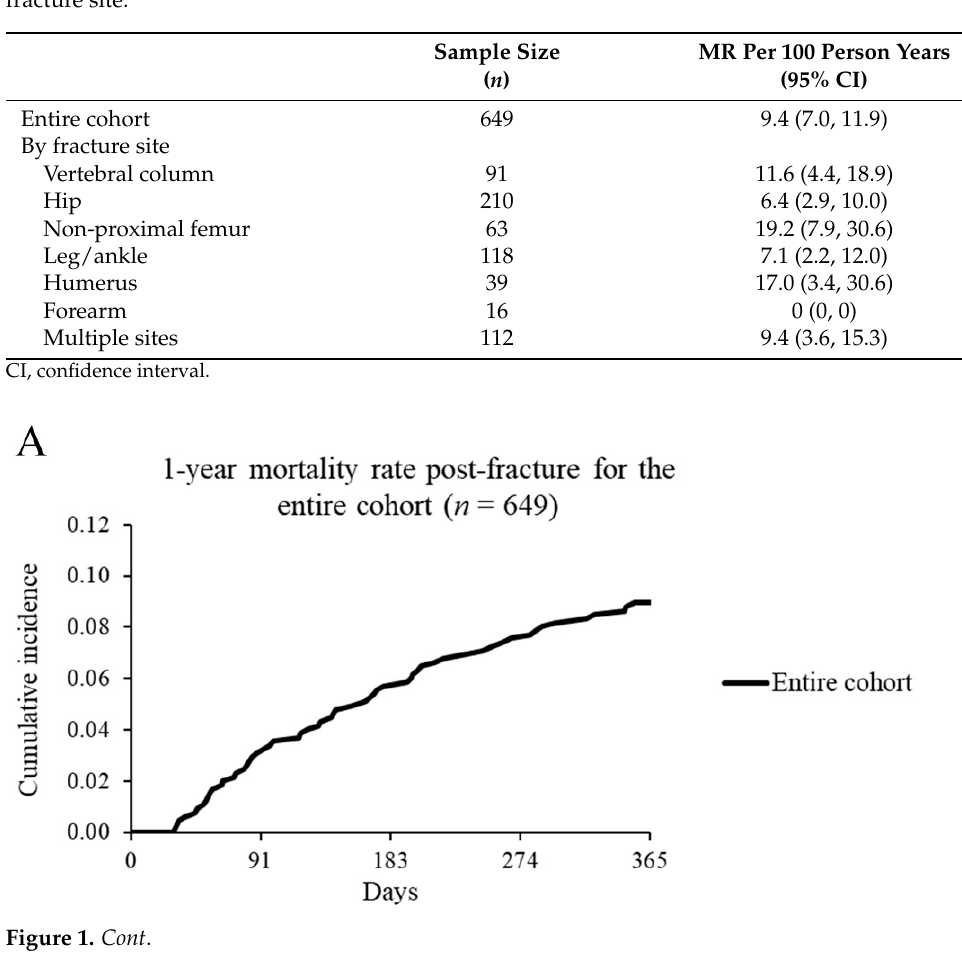
Figure 1. Mortality rate. Cumulative incidence of mortality from 31 days to 1-year post-fracture among ( A ) the entire cohort of adults with cerebral palsy with an incident fragility fracture and ( B ) then by fracture site. 3.4. Association between PT/OT Use and 1-Year Mortality As hypothesized, there was evidence of an interaction between acute care/rehabili- tation average PT/OT cost/day with the length of stay in unadjusted and adjusted models (both p for interaction, ≤ 0.001). The unit of measurement for the average PT/OT cost/day (continuous variable) was set to USD 60/day. This was done to produce an effect estimate that is more readily interpretable as compared to a much smaller effect estimate when modelling the continuous exposure as USD 1/day. All other model and statistical param- eters are unchanged with this transformation. The average PT/OT cost/day was associated with lower mortality rate, but the effect diminished linearly with increasing length of stay until ~17 days, after which the association became non-significant and then significantly associated with increased mortality rate (Figure 2).